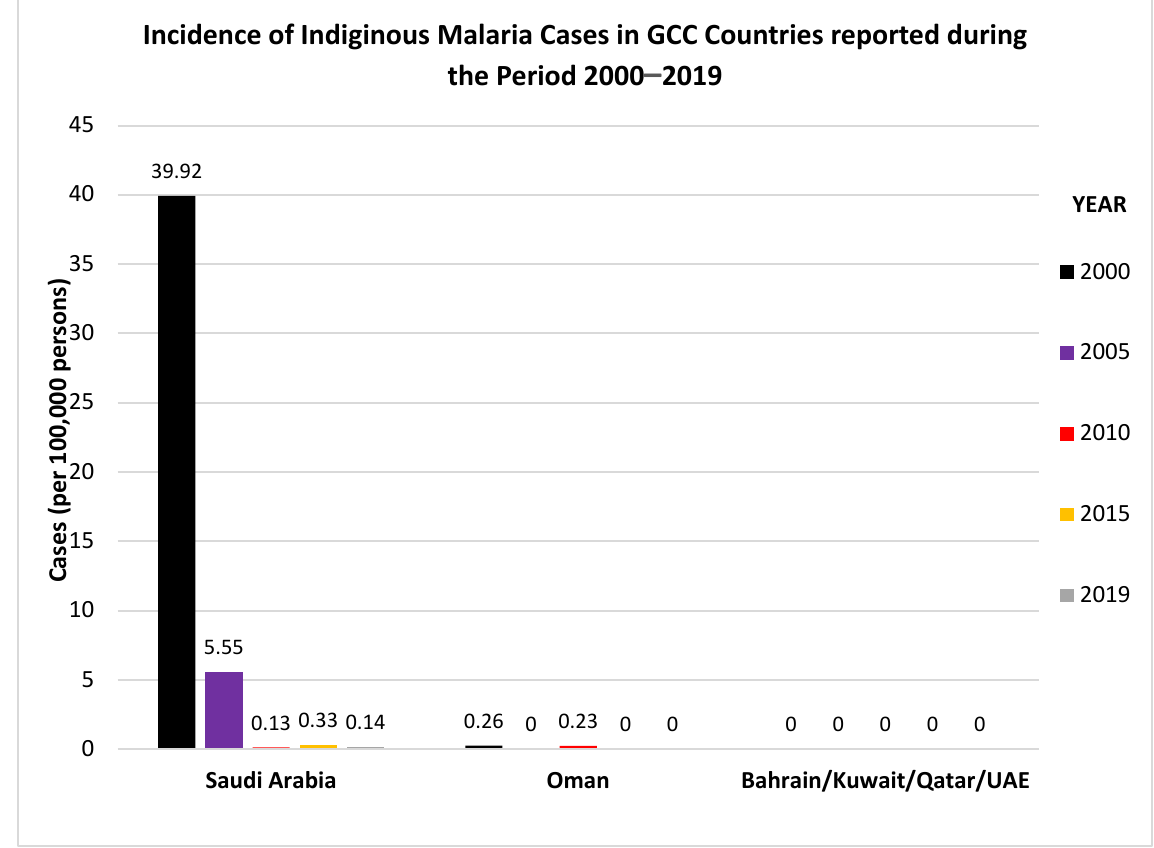
Figure 1. Incidence of indigenous malaria cases in GCC Countries reported during the Period 2000–2019. The graphs were made using data adopted from WHO, World Malaria Reports, 2019 and 2020 and Malaria Atlas Project 2019 (https: //malariaatlas.org/malaria-burden-data-download/ accessed on 20 March